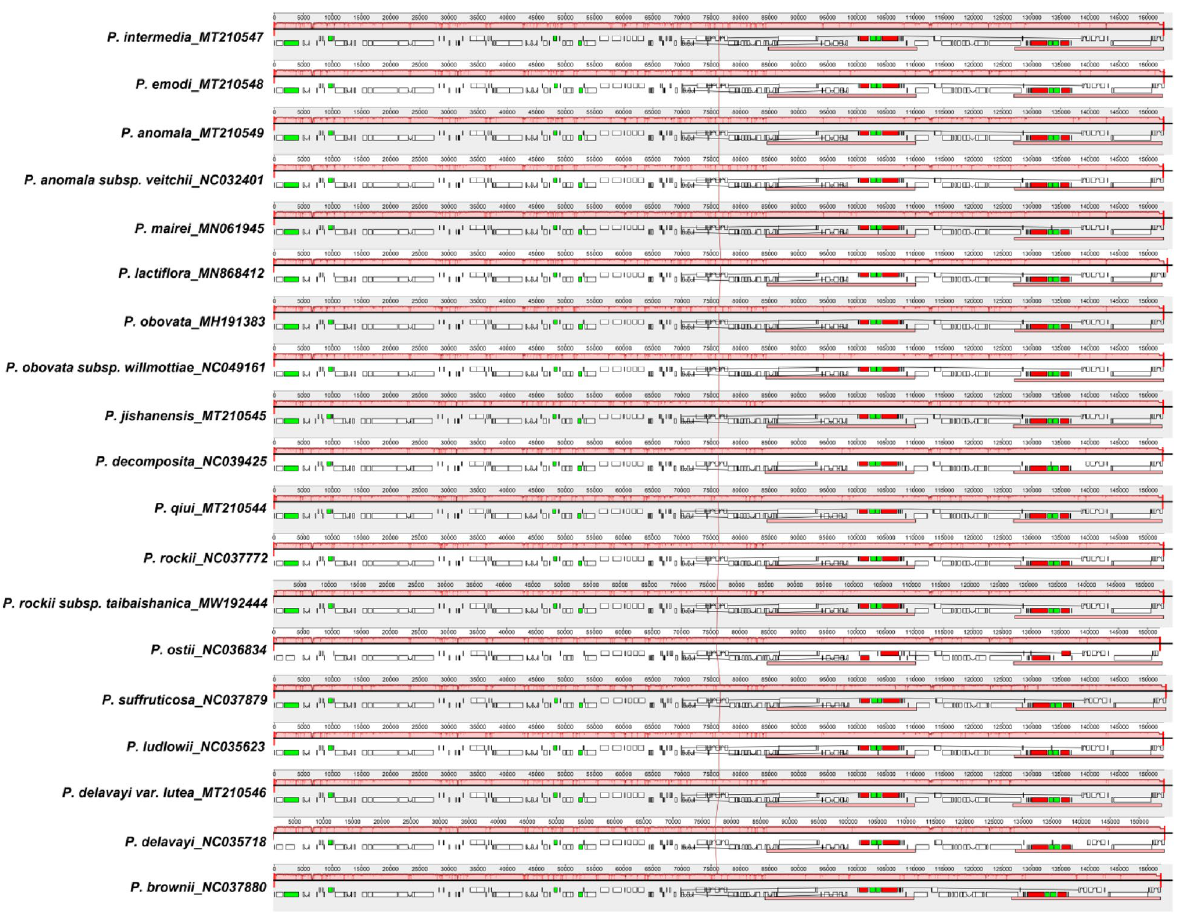
Figure 6. Co-linear analysis of 19 Paeoniaceae species chloroplast genomes. Local collinear blocks are represented by blocks of the same color connected by